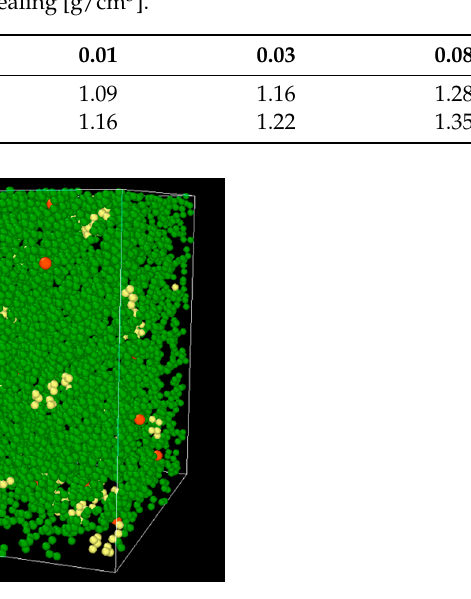
Figure 2. A snapshot of PEO system at a salt concentration of 0.01. PEO polymer is shown as green particles and Li and TFSI ions are shown as orange and yellow particles, respectively.